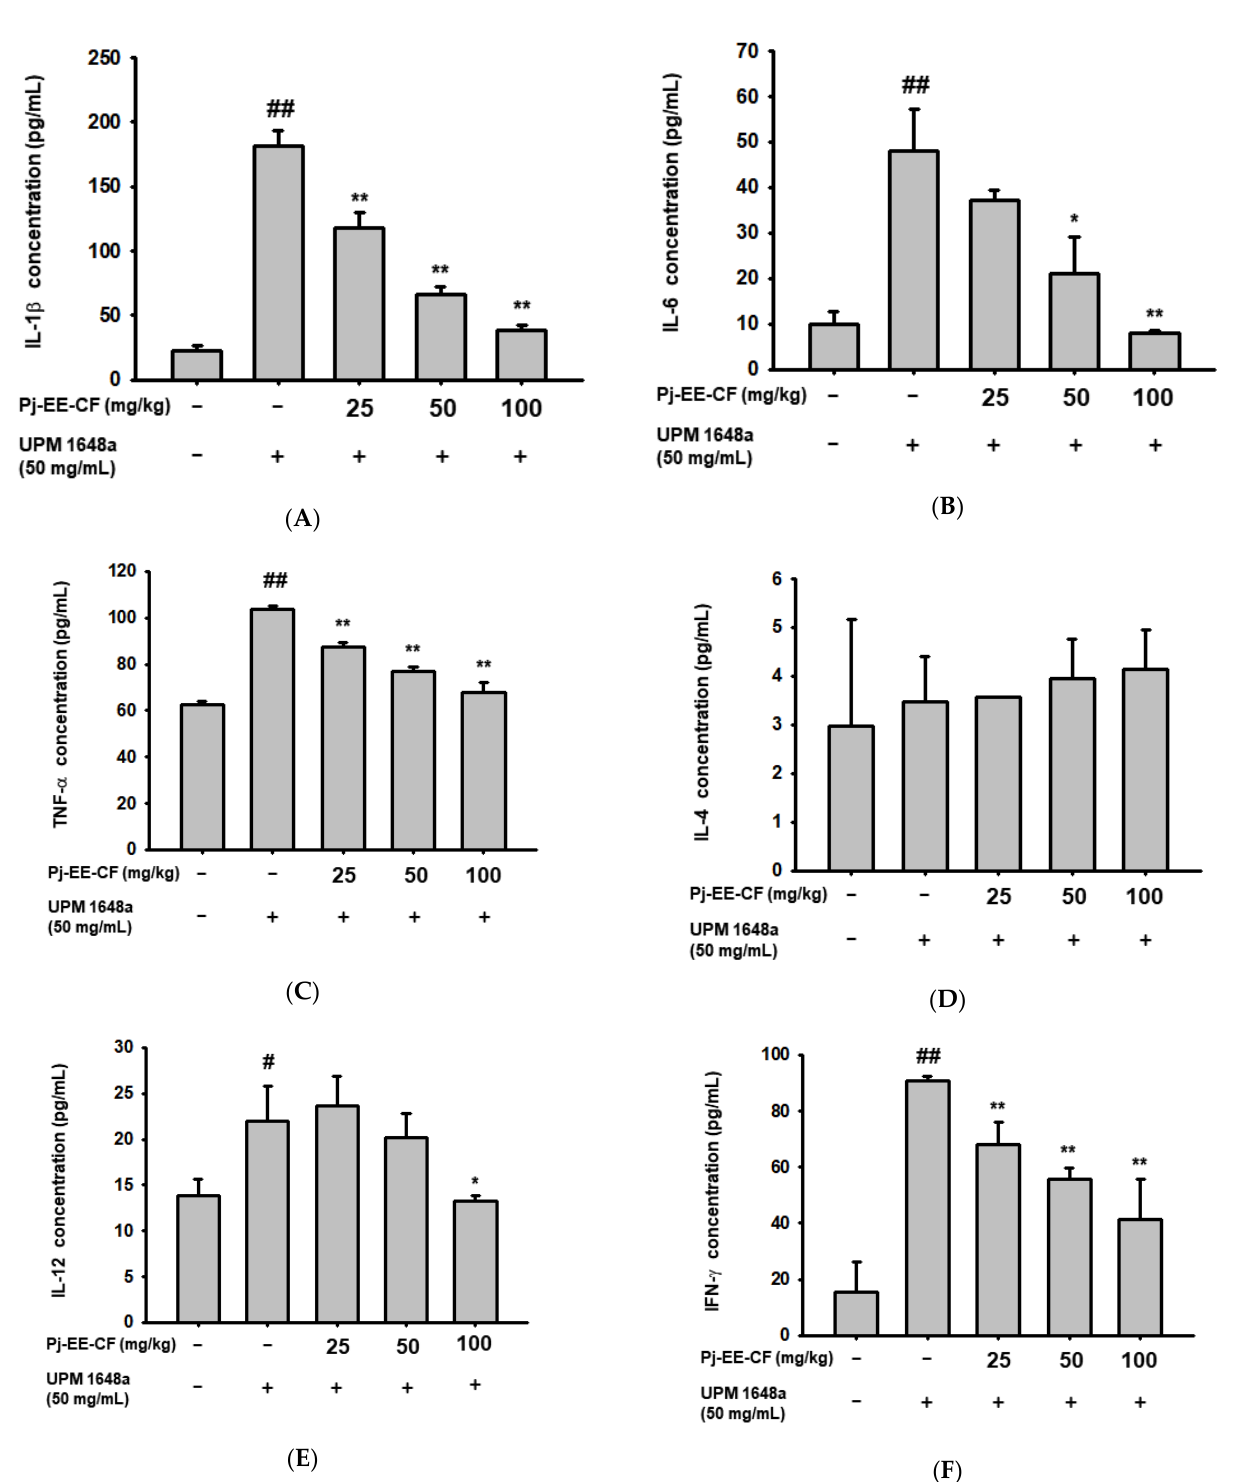
Figure 4. Inflammatory cytokine levels in mouse lung tissue homogenates after UPM 1648a instillation and Pj-EE-CF administration. IL-1 β ( A ), IL-6 ( B ), TNF- α ( C ), IL-4 ( D ), IL-12 ( E ), and IFN- γ ( F ) concentrations were determined by ELISA with lung lysates of 5 mice. All data are presented as mean ± SD (standard deviation) of the five biological replicates (n = 5 mice/group). # p < 0.05 and ## p < 0.01 compared to normal (non-treatment), * p < 0.05 and ** p < 0.01 compared to control (UPM 1648a